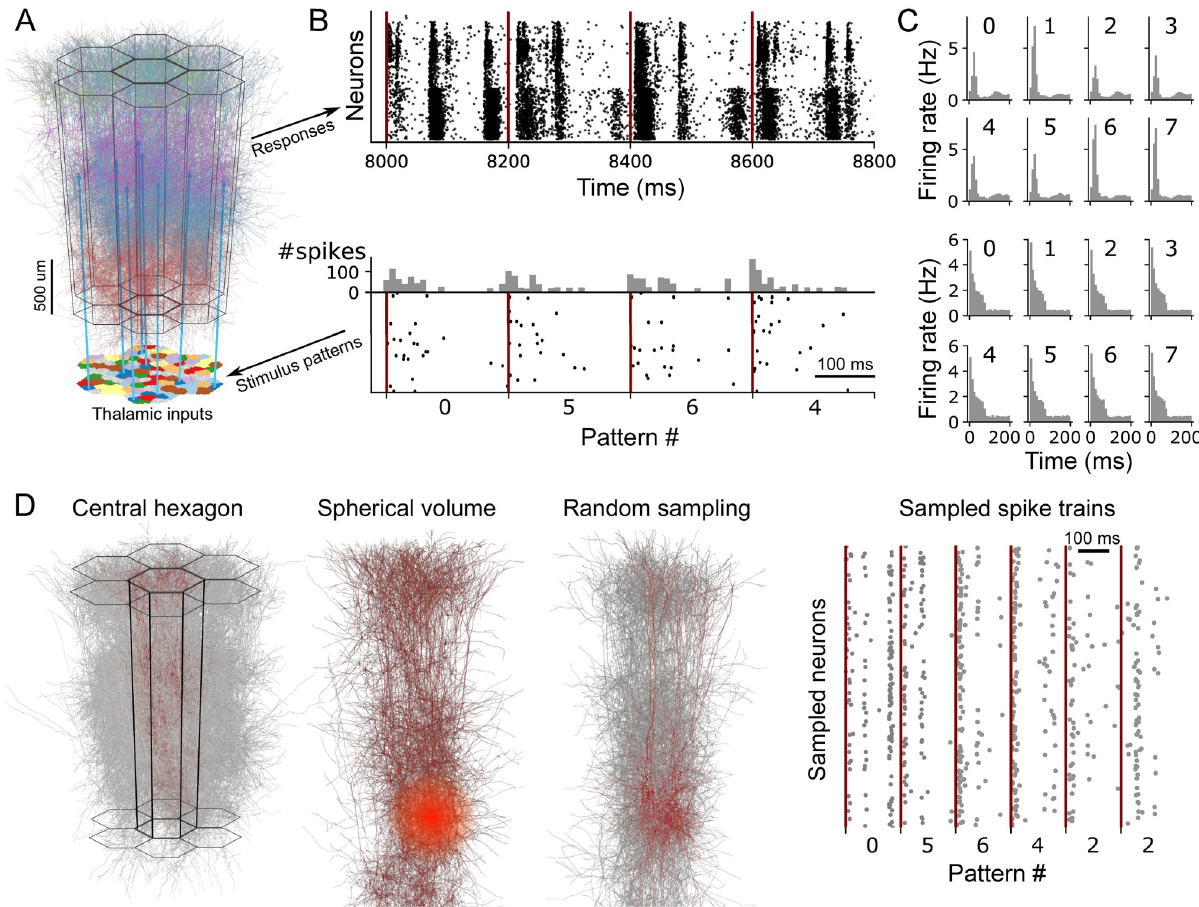
Fig 1. Synaptic input patterns applied to the detailed microcircuit model. A: The modeled microcircuit includes 2170 input fibers grouped into 100 bundles of nearby fibers modelling thalamo-cortical afferents. B: Spike trains are prescribed to the fibers to serve as stimulus patterns. Each pattern is associated with 10 randomly selected bundles of fibers. Each repetition of a pattern activates the associated fibers with an adapting Markov process, i.e. repetitions of a pattern use the same fibers, but with different stochastic spike trains. We apply a stream of 4495 repetitions of one of 8 stimulus patterns in random order (bottom) and simulate the microcircuits response (top). Raster plot of spiking responses is sorted by the layer of the simulated neuron, with layer 1 at the top and layer 6 at the bottom C: PSTHs of the input (bottom) and population spiking response (top) for each stimulus. D: Random sampling: We sample at random offsets by randomly picking 600 neurons from all neurons within a given radius and consider their spike trains for further analysis.